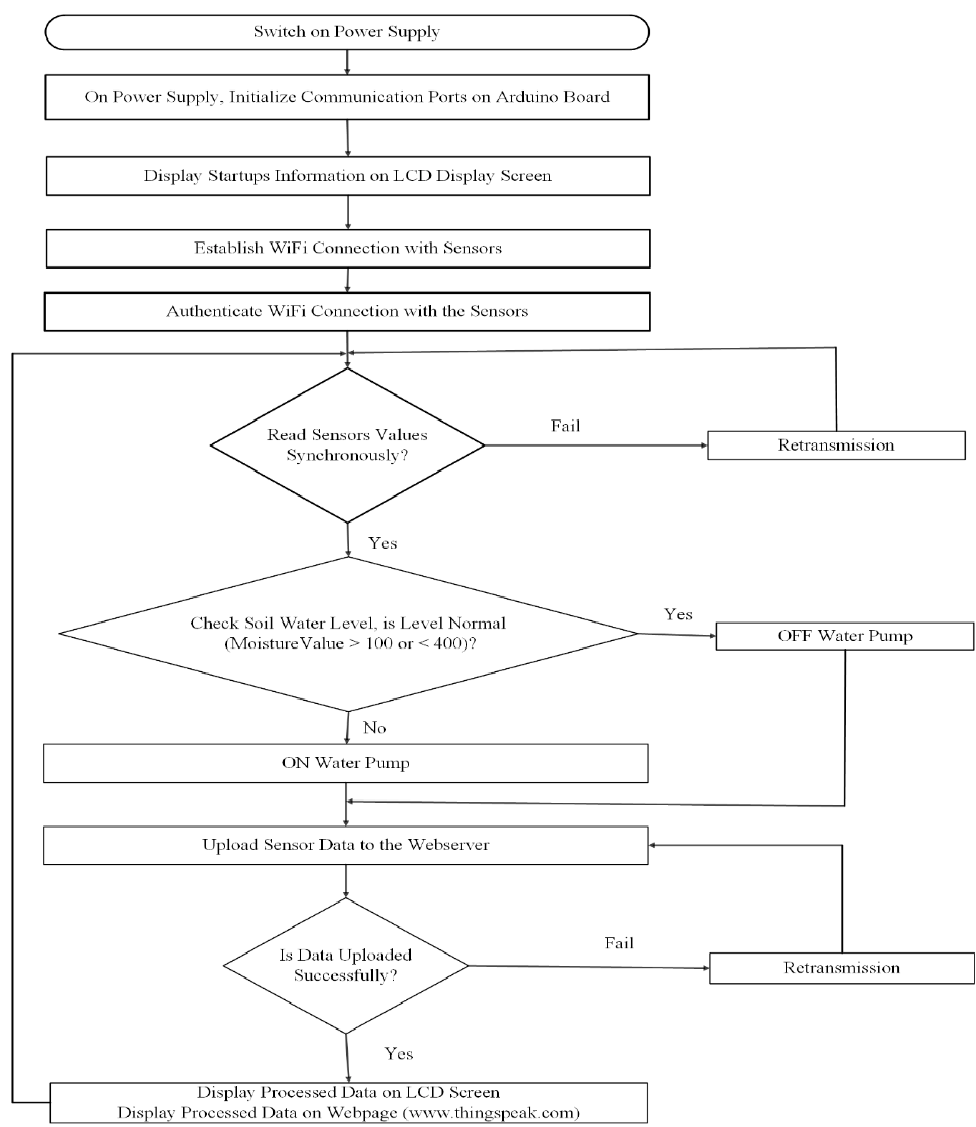
Figure 2. Real-time system monitoring and control.